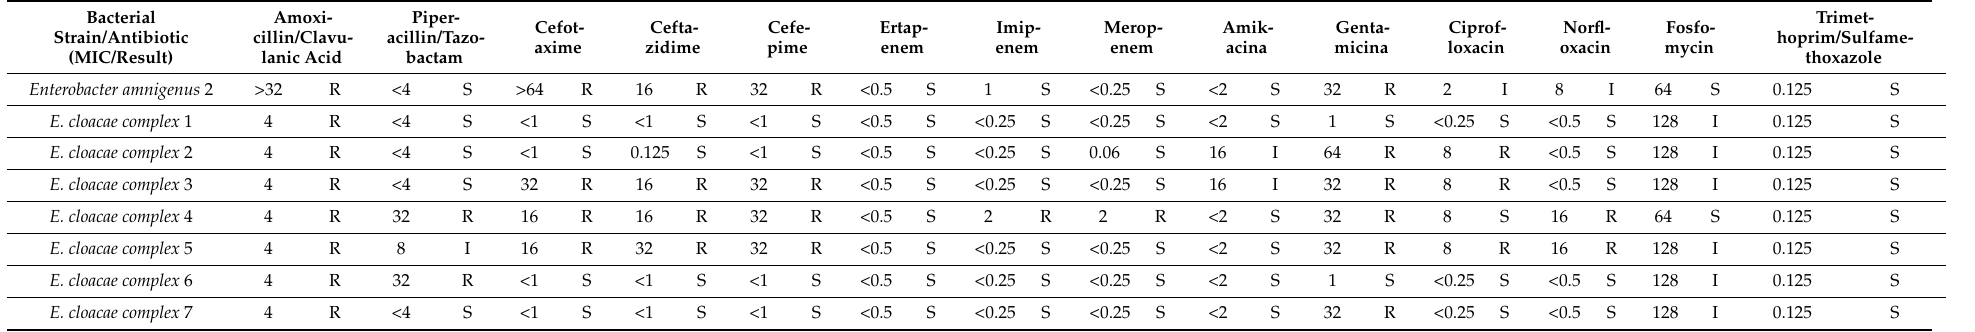
Table 8. MICs (mg/L) of antimicrobials for Enterobacter spp.